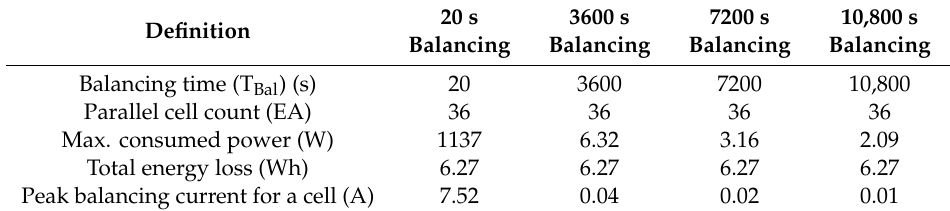
Table 6. Design and analysis of the PCB circuit for the 14S36P battery module.